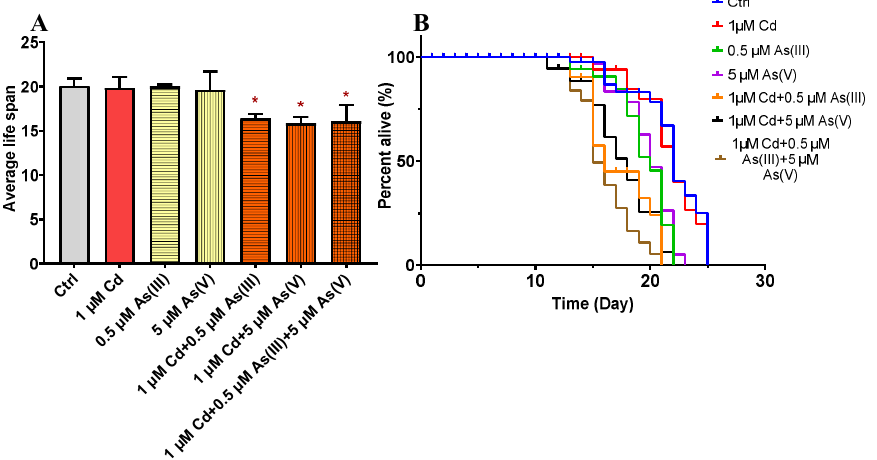
Figure 3. Effects of single and co-exposure to non-toxic concentrations of Cd, As(III), and As(V) on ( A ) average life span and ( B ) survival rate. * means p < 0.05.